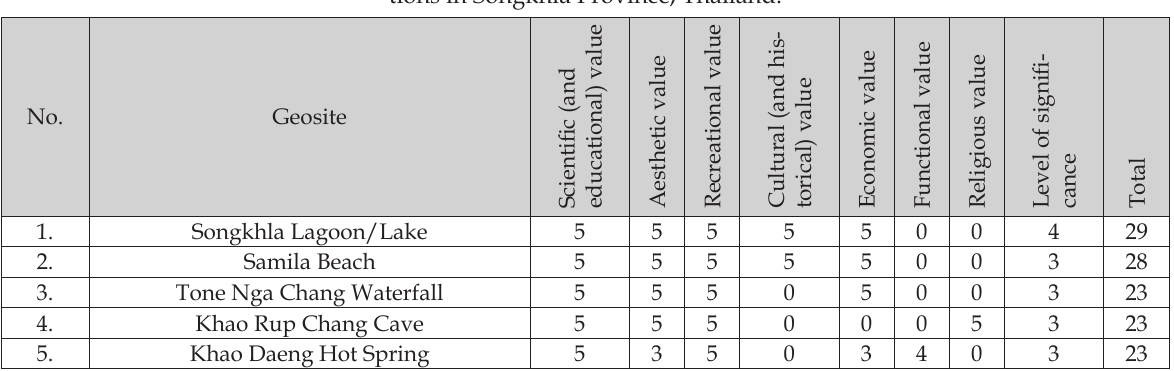
Table 4. Numerical assessment of selected geosites for potential geoheritage resources and geotourism attrac ­ tions in Songkhla Province,